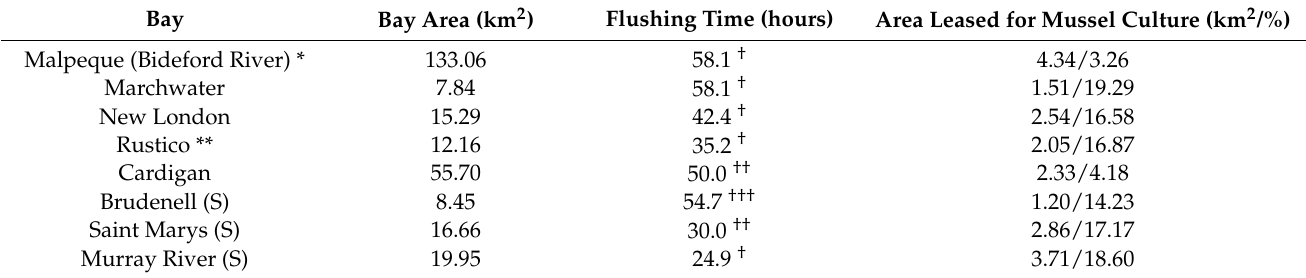
Table 1. Estimated total bay area, flushing time, and area leased for mussel culture and % of bay leased for mussel grow-out in 2005, for each bay sampled (data from Fisheries and Oceans Canada, Charlottetown, 2007). (S) indicates bays with Styela clava . Except for where indicated, farming in all sites was started in the early 1980s